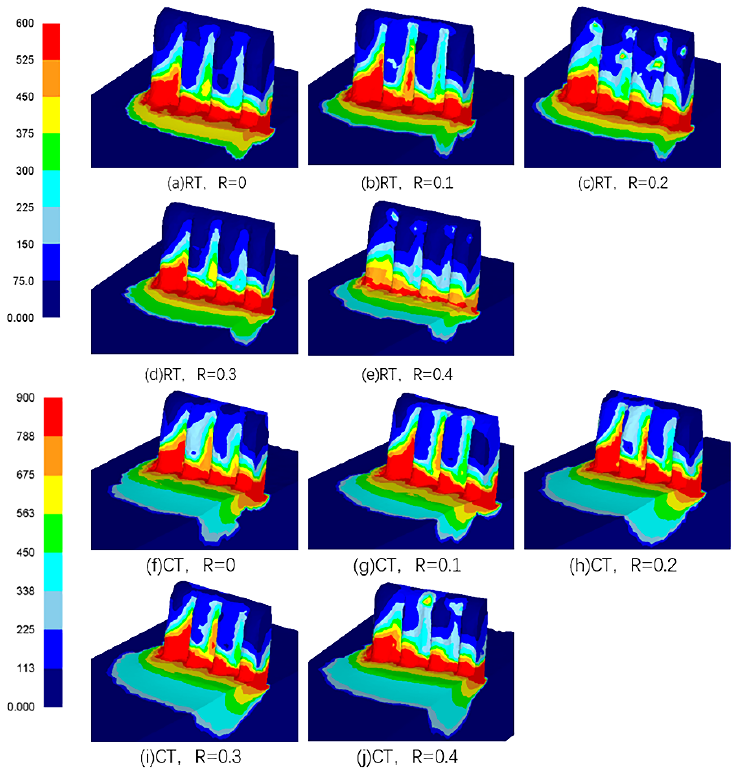
Figure 22. Effective stress distribution of the fins under different conditions.